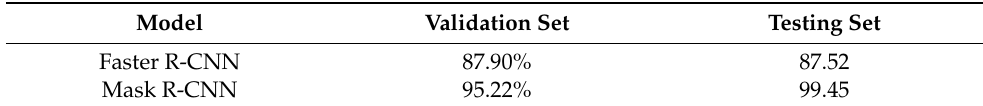
Table 2. mAP results from 3D camera datasets using Mask R-CNN and Faster R-CNN in the testing set and validation set.